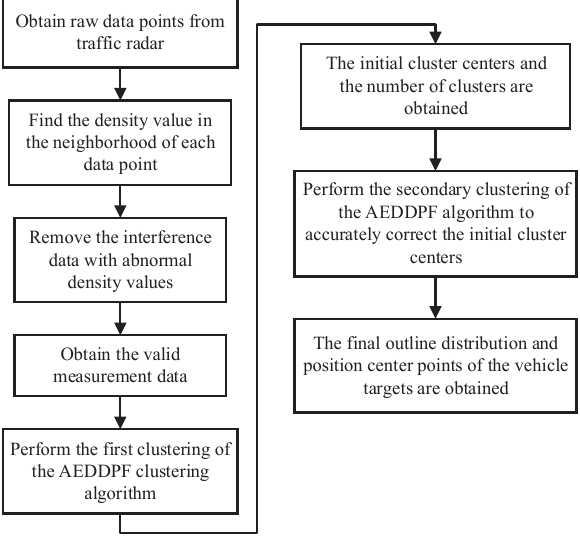
Figure 5. Flow chart of data processing.